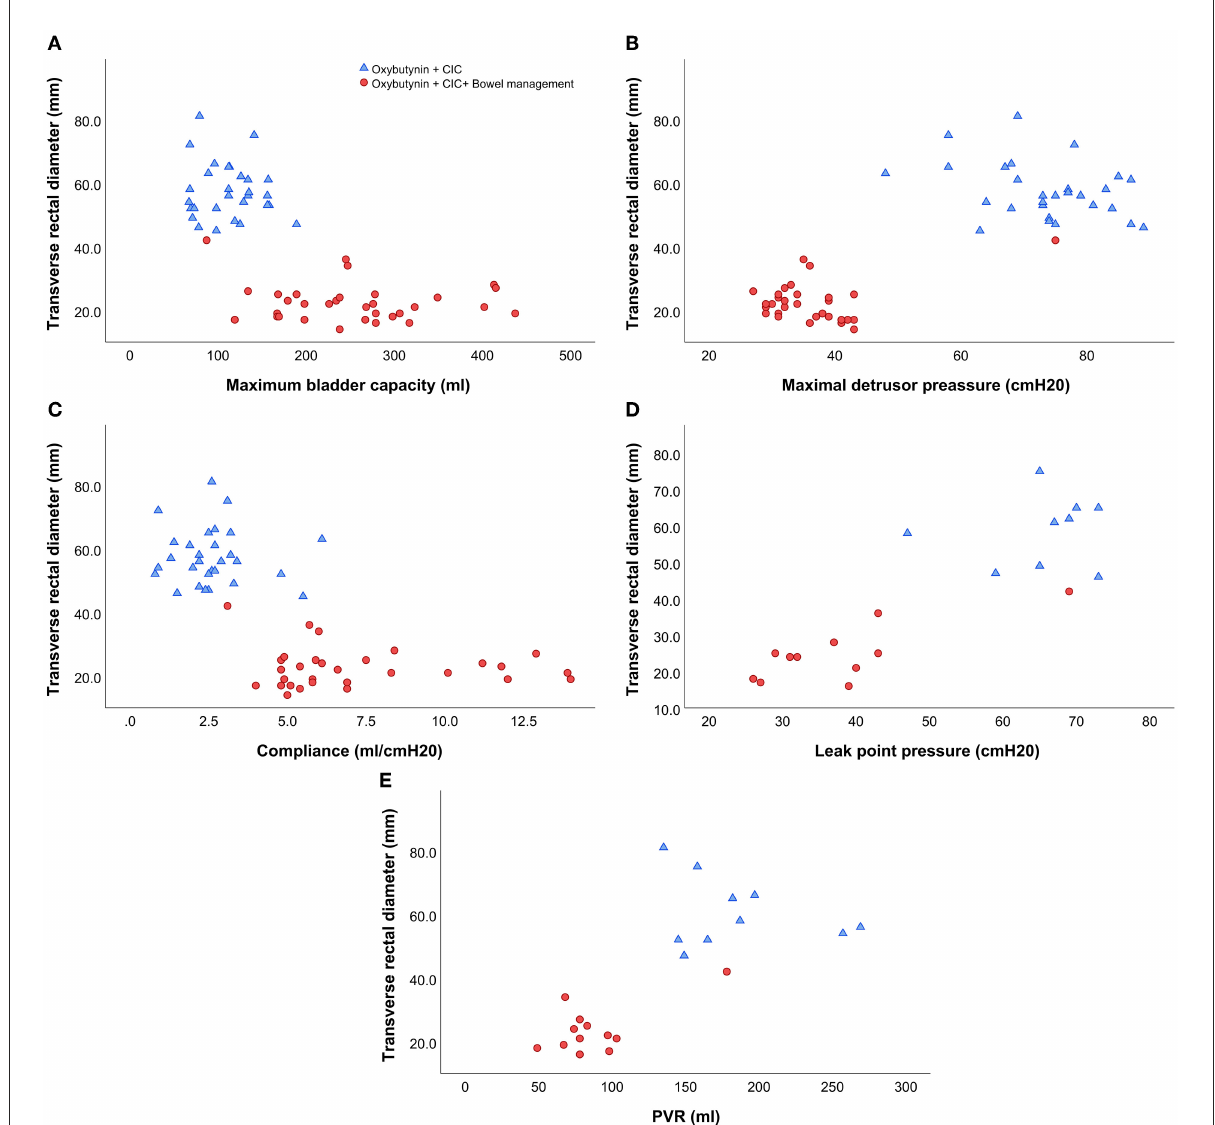
FIGURE1 The correlation between urodynamic parameters and transverse rectal diameter stratified by therapy regimen. (A) The correlation between transverse rectal diameter and maximum bladder capacity. (B) The correlation between transverse rectal diameter and maximal detrusor pressure. (C) The correlation between transverse rectal diameter and compliance. (D) The correlation between transverse rectal diameter and leak point pressure. (E) The correlation between transverse rectal diameter and